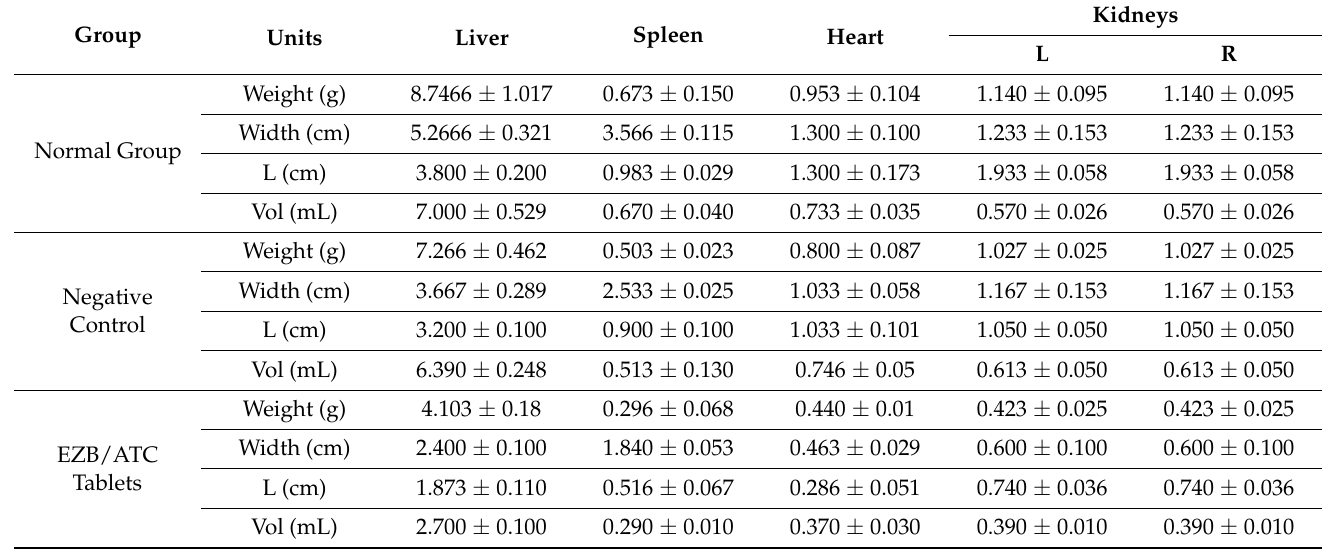
ment was significant on all vitals organs’ weight, width, length and volume values, com- pared to the negative control group. Results are shown in Table 7. Table 7. Effect of atorvastatin and ezetimibe on vital organs of rats in curative study.